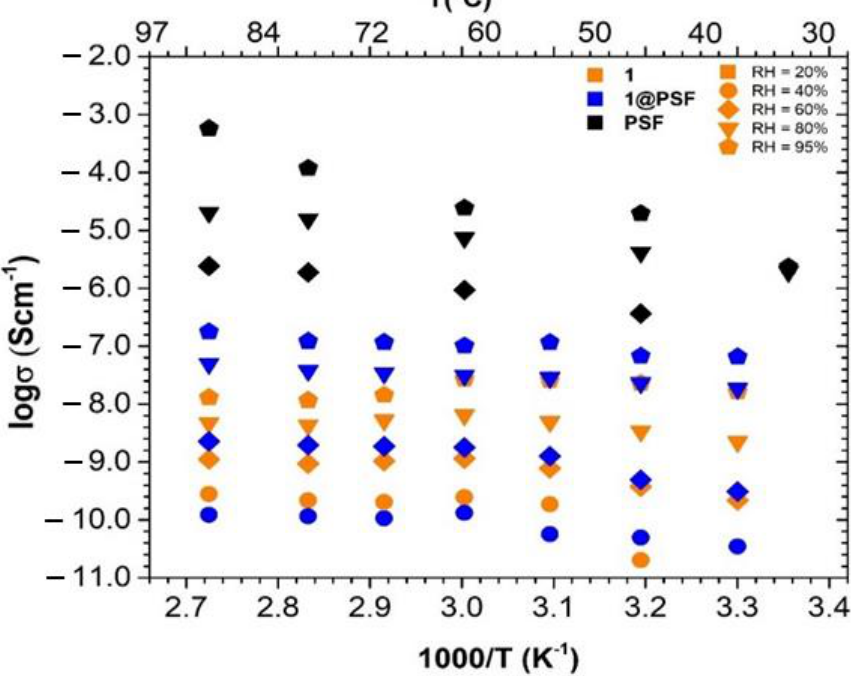
Figure 6. Arrhenius plots for the ionic conductivity of compound 1 , 1@PSF membrane and pristine PSF in-plane conductivity measured under variable RH and temperature.